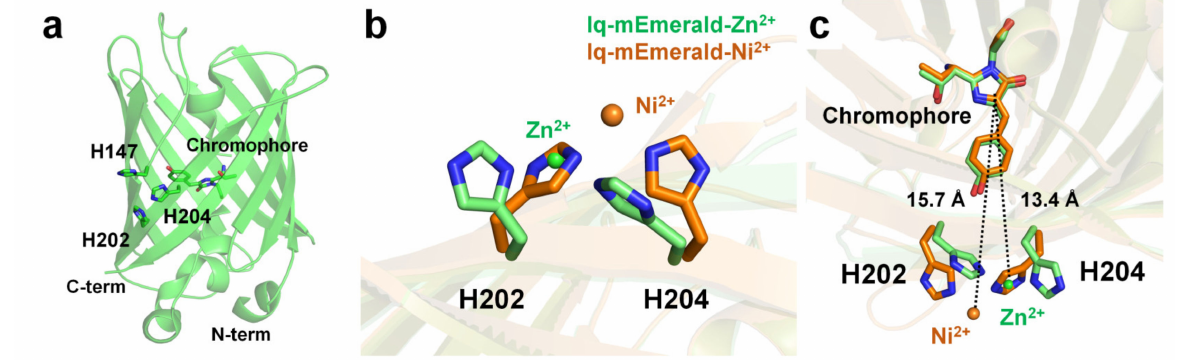
Figure 5. Crystal structure of the native and metal-bound states of iq-mEmerald. ( a ) Engineered sites (H147, H202 and H204) of iq-mEmerald for metal binding. ( b , c ) Comparison of the metal-binding site between apo (green) and nickel-bound (orange)